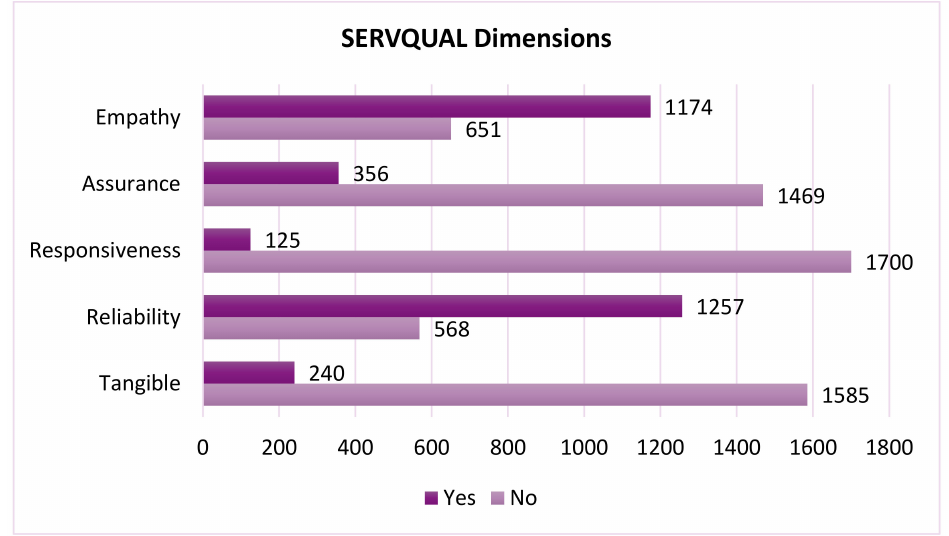
Figure 3. SERVQUAL dimensions classified by machine learning classifier ( n = 1825).